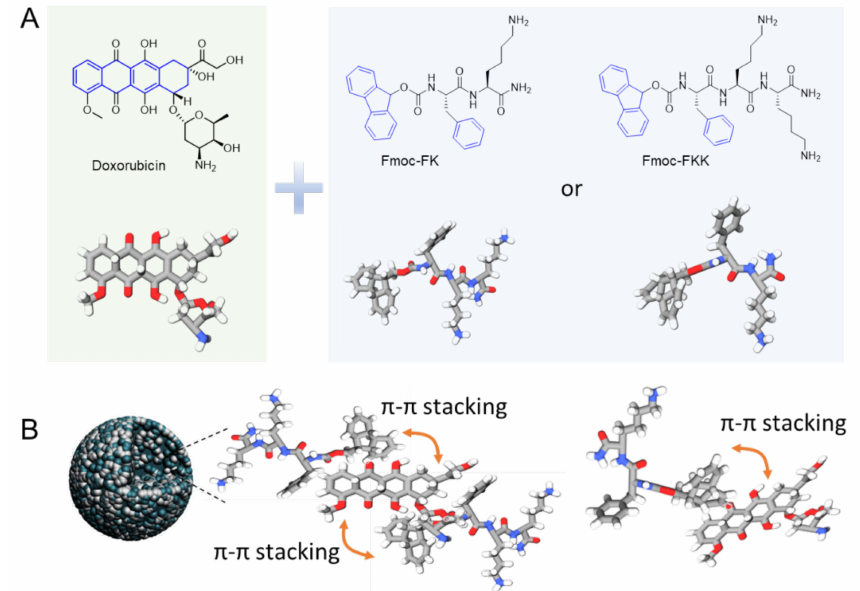
Figure 2. ( A ) Chemical structures and representative three-dimensional branch view of the Dox, Fmoc-FK, and Fmoc-FKK. ( B ) Proposed molecular packing in the assembled nanoparticles. It is anticipated that the π – π stacking interaction between aromatic rings will dominate the assembly kinetics.